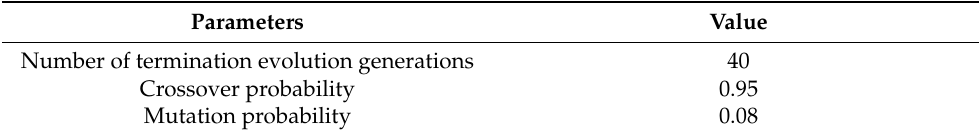
Table 7. GA algorithm